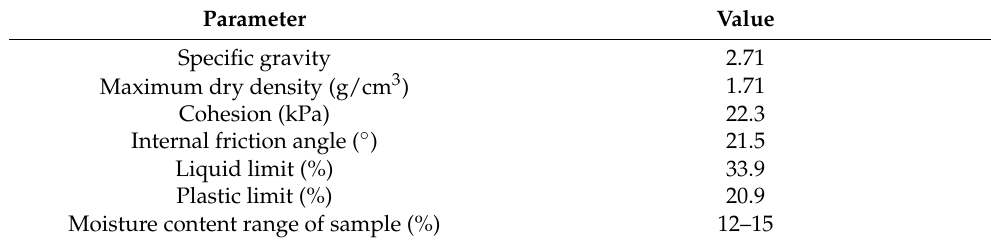
Table 2. Physical parameters of loess.